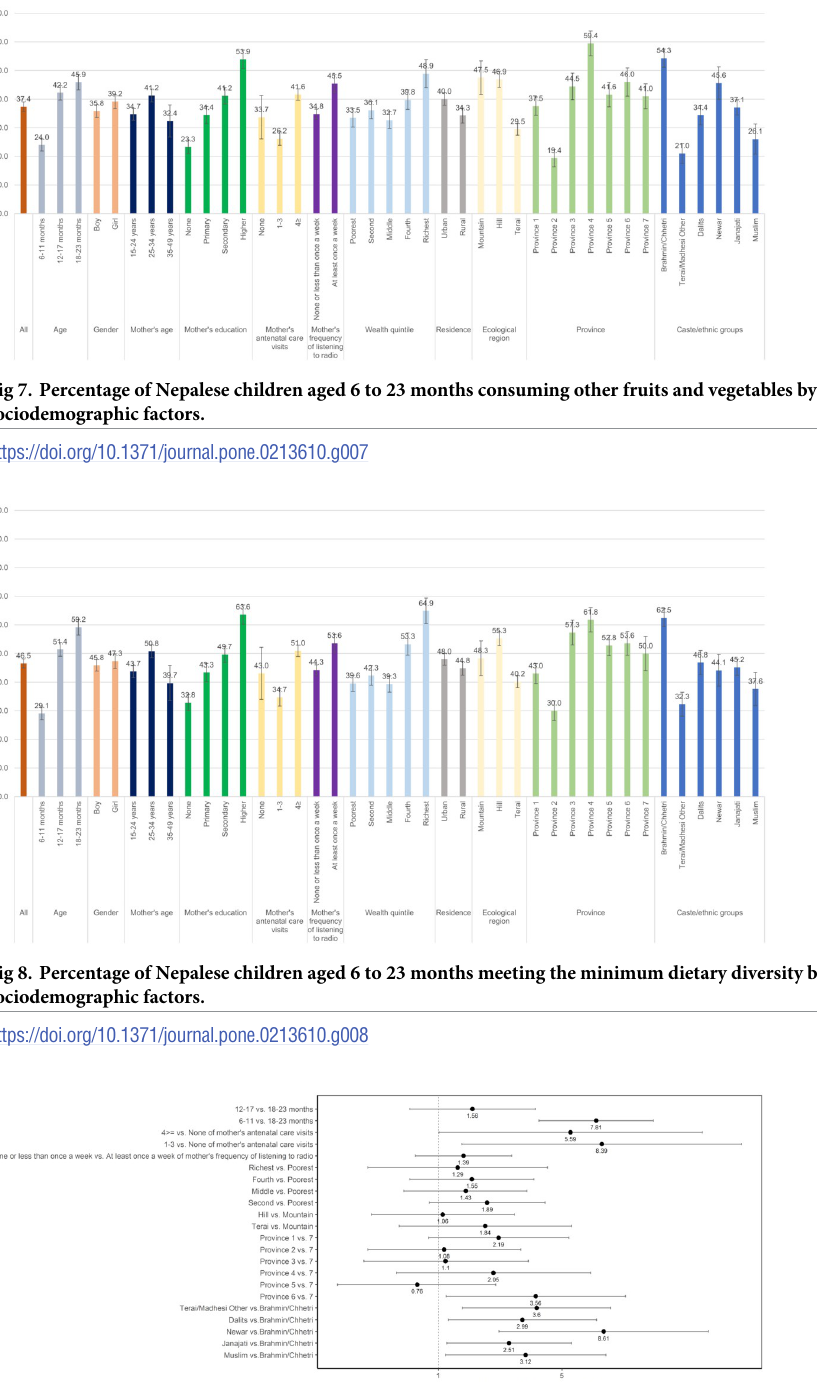
Fig 9. Odds ratio plot with 95% confidence intervals for not consuming grains, roots and tubers among Nepalese children aged 6 to 23 months.